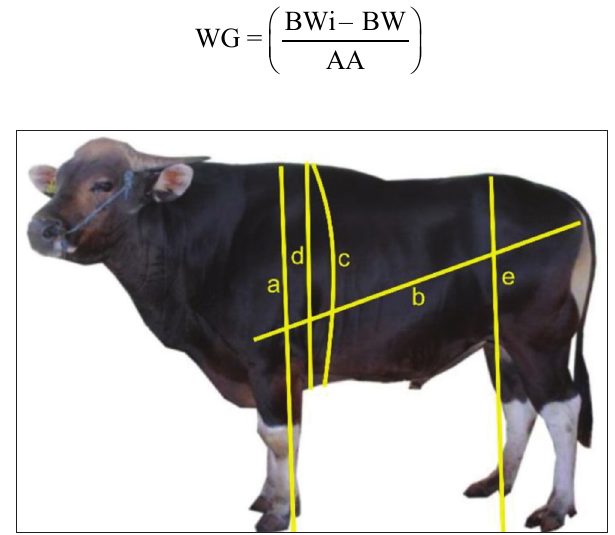
Figure-1: Body measurement of Bali cattle according to SNI 7651-4: 2017. Line (a) represents withers height; (b) body length; (c) chest girth; (d) chest depth; and (e) waist